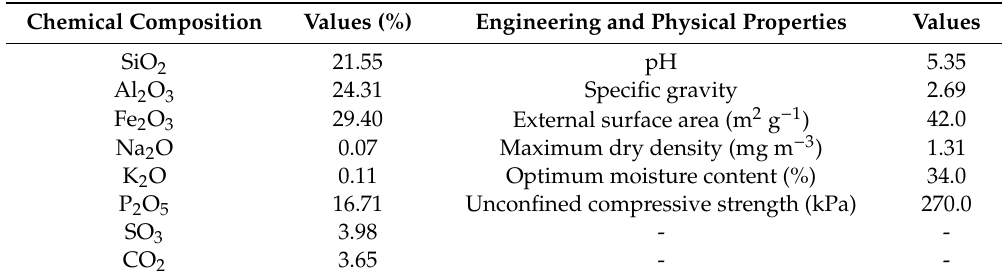
Table 1. Physical and chemical properties of natural laterites